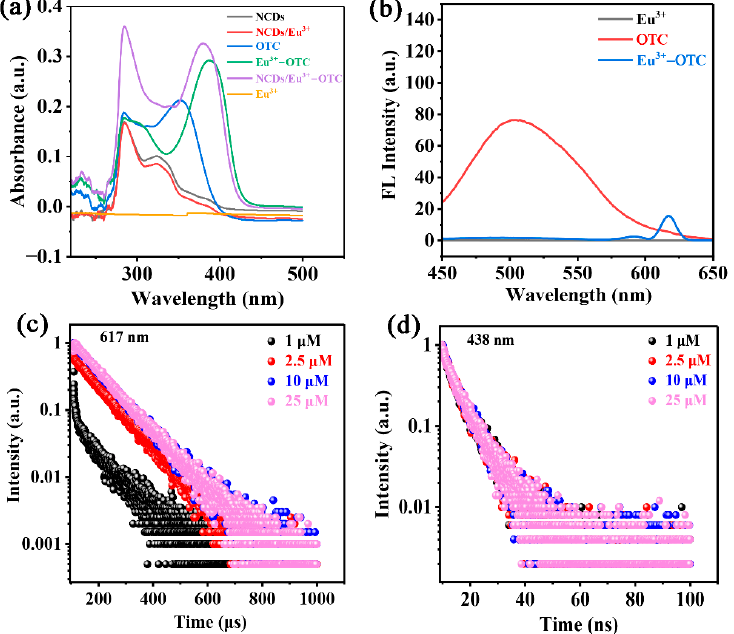
Figure 5. UV–Vis adsorption spectra ( a ) and fluorescence spectra ( b ) of different systems. Fluores- cence lifetime decay curves of the NCDs/Eu 3+ probe at 617 nm ( c ) and 438 nm ( d ) after incubation with OTC at different concentrations.